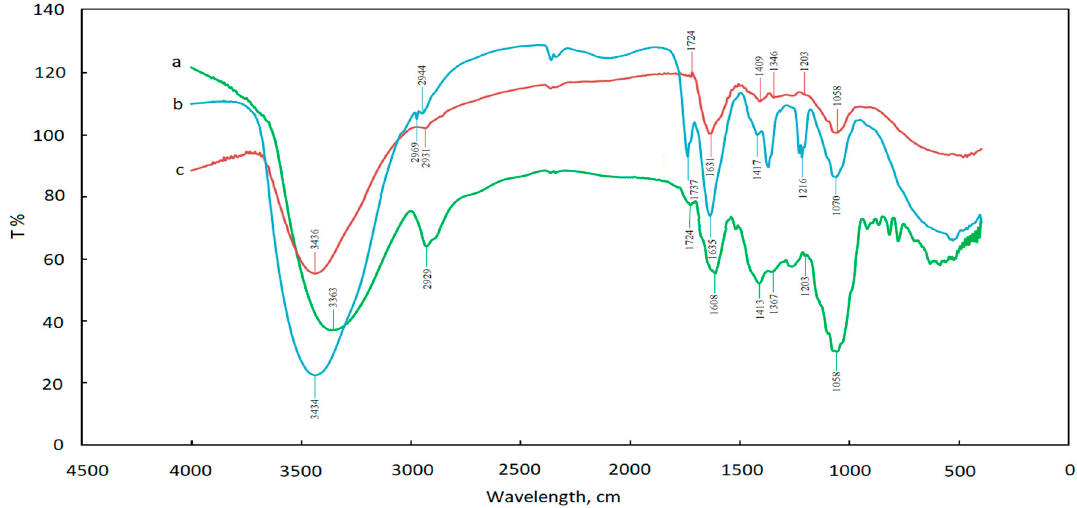
Figure 7. The FT-IR spectra of AuNPs solution obtained from C. sinensis peel extract at different experiment conditions: ( a ) control; ( b ) pH adjust to 11 before AuPNs synthesize reaction happen; ( c ) pH adjust to 11 after AuPNs synthesize reaction happen.